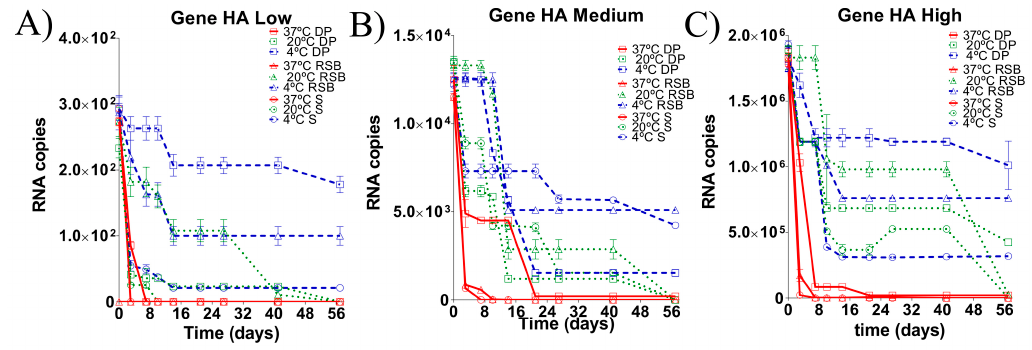
Figure 2. Comparison of RNA load values detected from the HA gene diagnostic target region under different storage conditions for 57 days post incubation (dpi). Dynamic of degradation at ( A ) low RNA load, ( B ) medium RNA load and ( C ) high RNA load. Each matrix of storage is denoted (S: swab matrix, RSB: RNA safe buffer described by Hoffmann et al. (2006) modified in this study, DP: dry pellet matrix), each temperature of storage is also denoted. Data is mean of qRT-PCR from triplicate samples. Based on the limit of detection of the assay, samples with ct > 35 were considered negative (see Supplementary Materials Figure S1B).